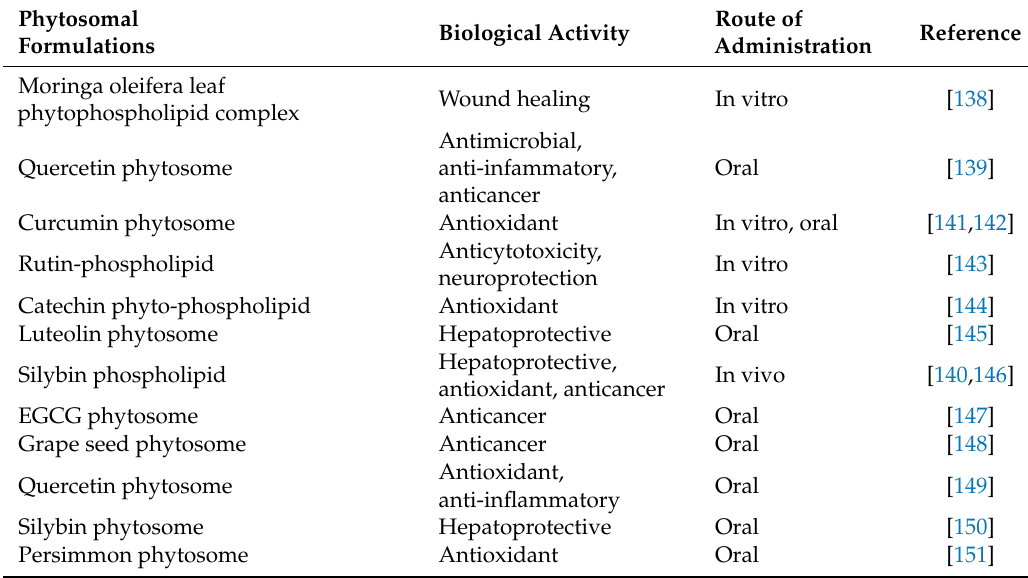
Table 3. Polyphenols complexed with